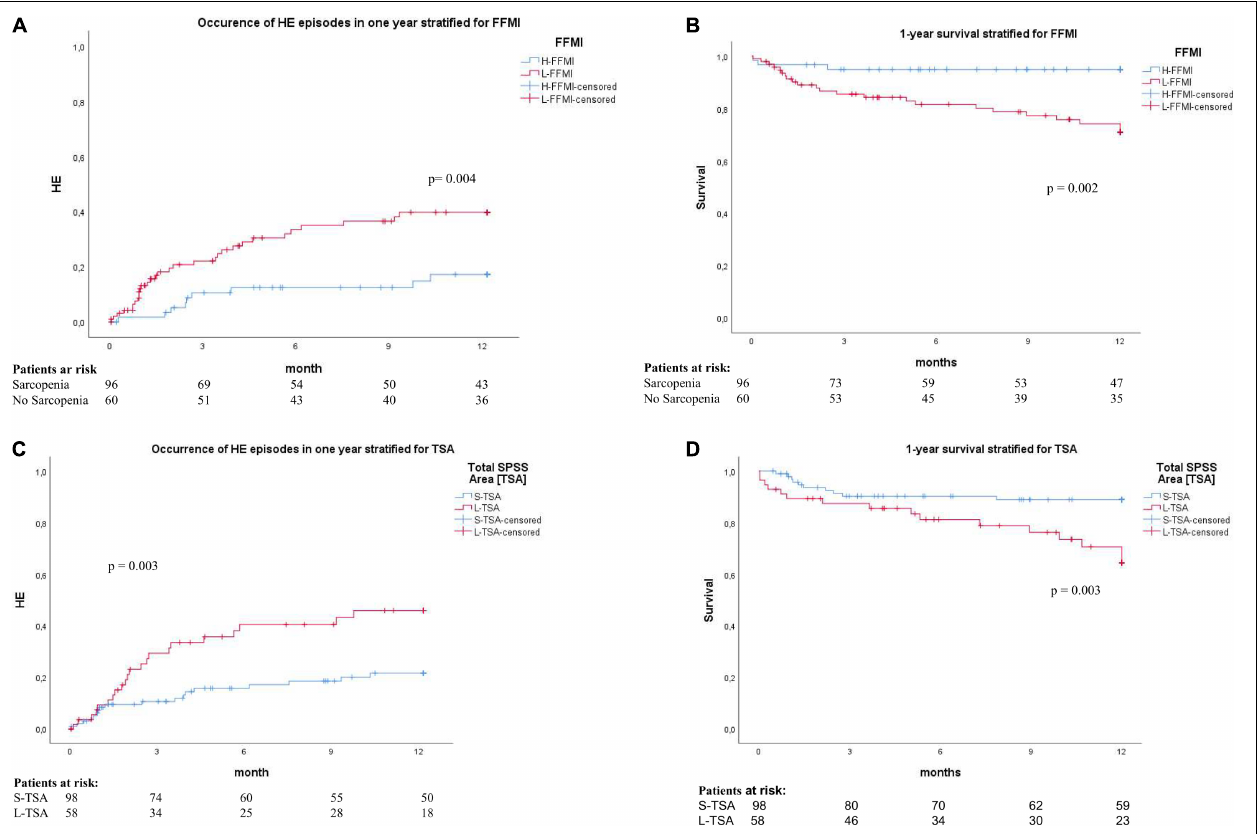
FIGURE 2 | (A) Cumulative incidence of development HE in the 1-year follow-up, stratified by FFMI. H-FFMI (high FFMI, blue line); L-FFMI (low FFMI, red line). P by log-rank. (B) Kaplan–Meier survival plot for 1-year survival, stratified by FFMI. H-FFMI (high FFMI, blue line); L-FFMI (low FFMI, red line). P by log-rank. (C) Cumulative incidence of development HE in the 1-year follow-up, stratified by TSA. S-TSA (small TSA, blue line); L-TSA (large TSA, red line). P by log-rank. (D) Kaplan-Meier survival plot for 1-year survival, stratified by TSA. S-TSA (small TSA, blue line); L-TSA (large TSA, red line). P by log-rank. TABLE 2 | Univariate/multivariate Cox regression analysis for 1-year HE-development. Parameters univariate Cox-Regression multivariate